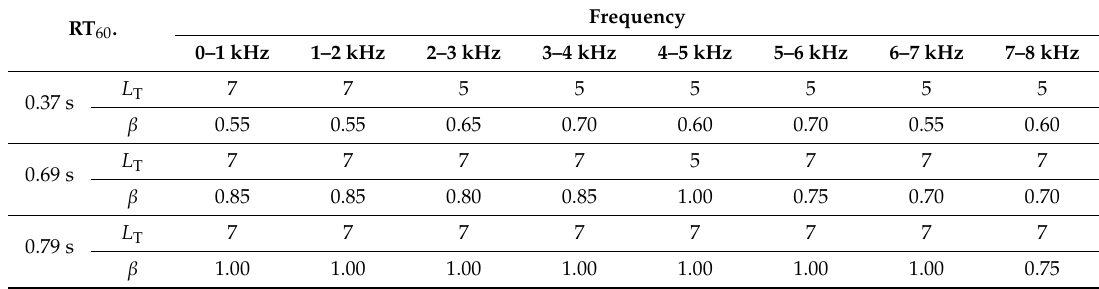
Table 3. Optimal L T and β according to the frequency intervals and reverberation environment using a 64-ms Hamming window, 16-ms hop length, and 1024-point FFT. RT 60